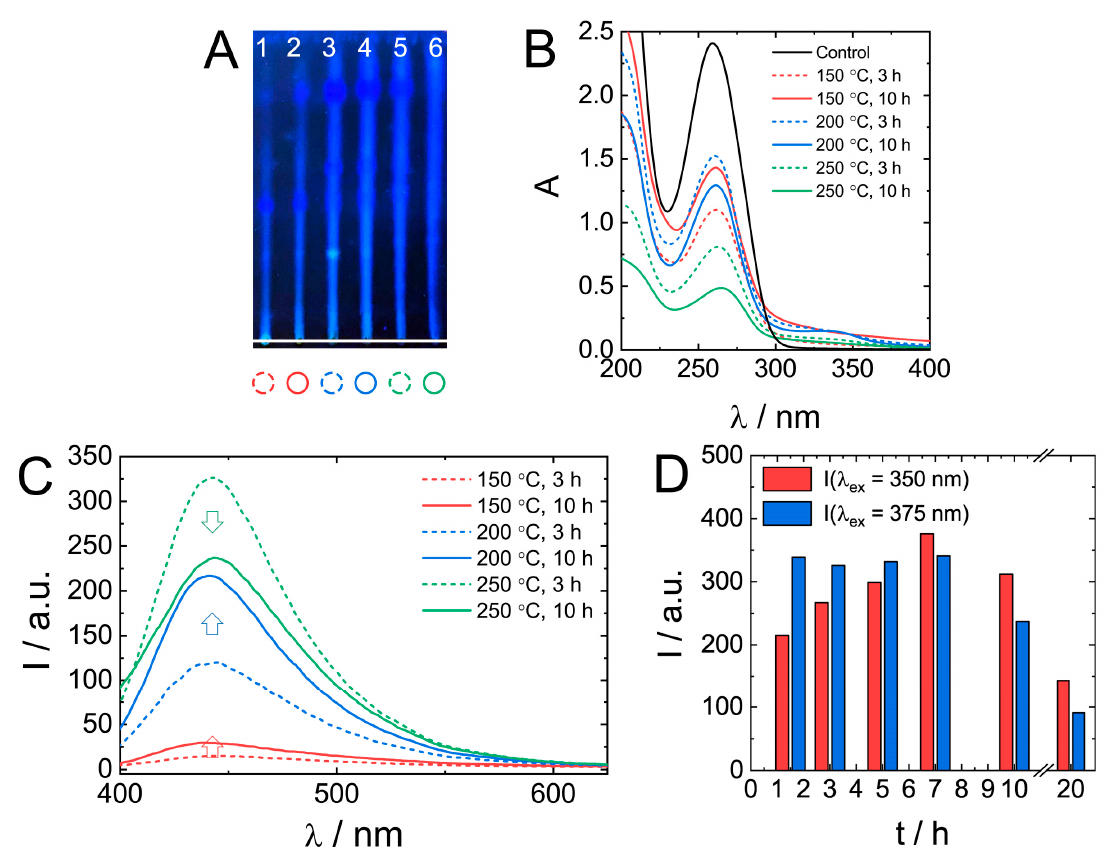
Figure 5. The effect of the HT synthetic conditions on nucleic acids biodots formation and their optical properties. ( A ). A thin layer chromatography of DNA biodots prepared under various treatment times and reaction temperatures (1–150 ◦ C, 3 h; 2–150 ◦ C, 10 h; 3–200 ◦ C, 3 h; 4–200 ◦ C, 10 h; 5–250 ◦ C, 3 h; 6–250 ◦ C, 10 h). A mixture of BuOH:AcOH:H 2 O = 4:1:2 was used as the mobile phase. ( B , C ). UV-vis absorbance spectra of 0.02% ( w / v ) DNA biodots solutions ( B ) and fluorescence spectra ( λ ex = 375 nm) of 0.033% ( w / v ) DNA biodot solutions ( C ) prepared under various treatment times and reaction temperatures. The control in B is the spectrum of the original DNA solution. ( D ). Dependences of the fluorescence intensity of DNA biodots at λ ex = 350 nm and 375 nm on the time of HT treatment at 250 ◦